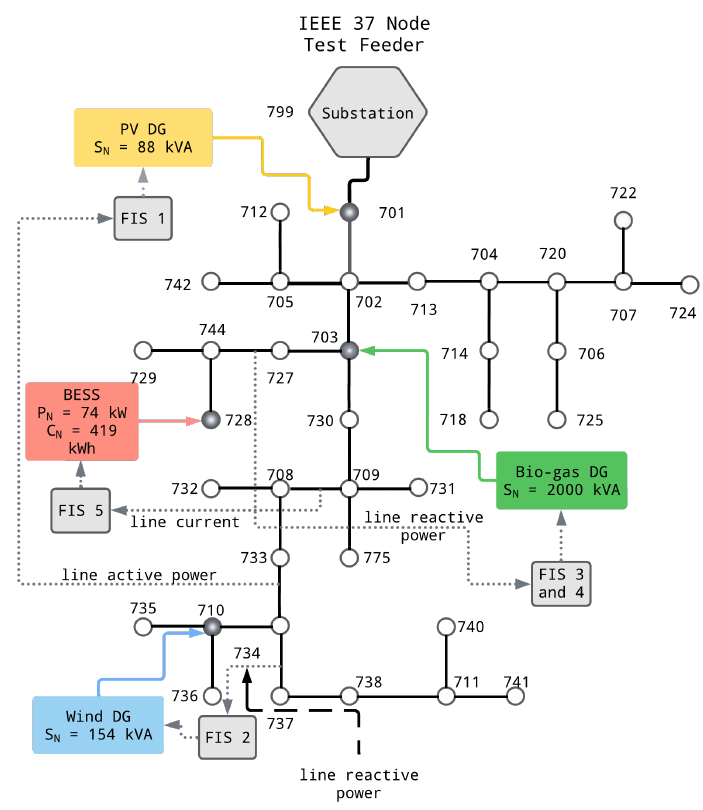
Figure 4. Obtained optimal allocation of BESS, DG and measured FIS inputs. Table 3. Optimized types of the physical quantities used as FIS inputs.